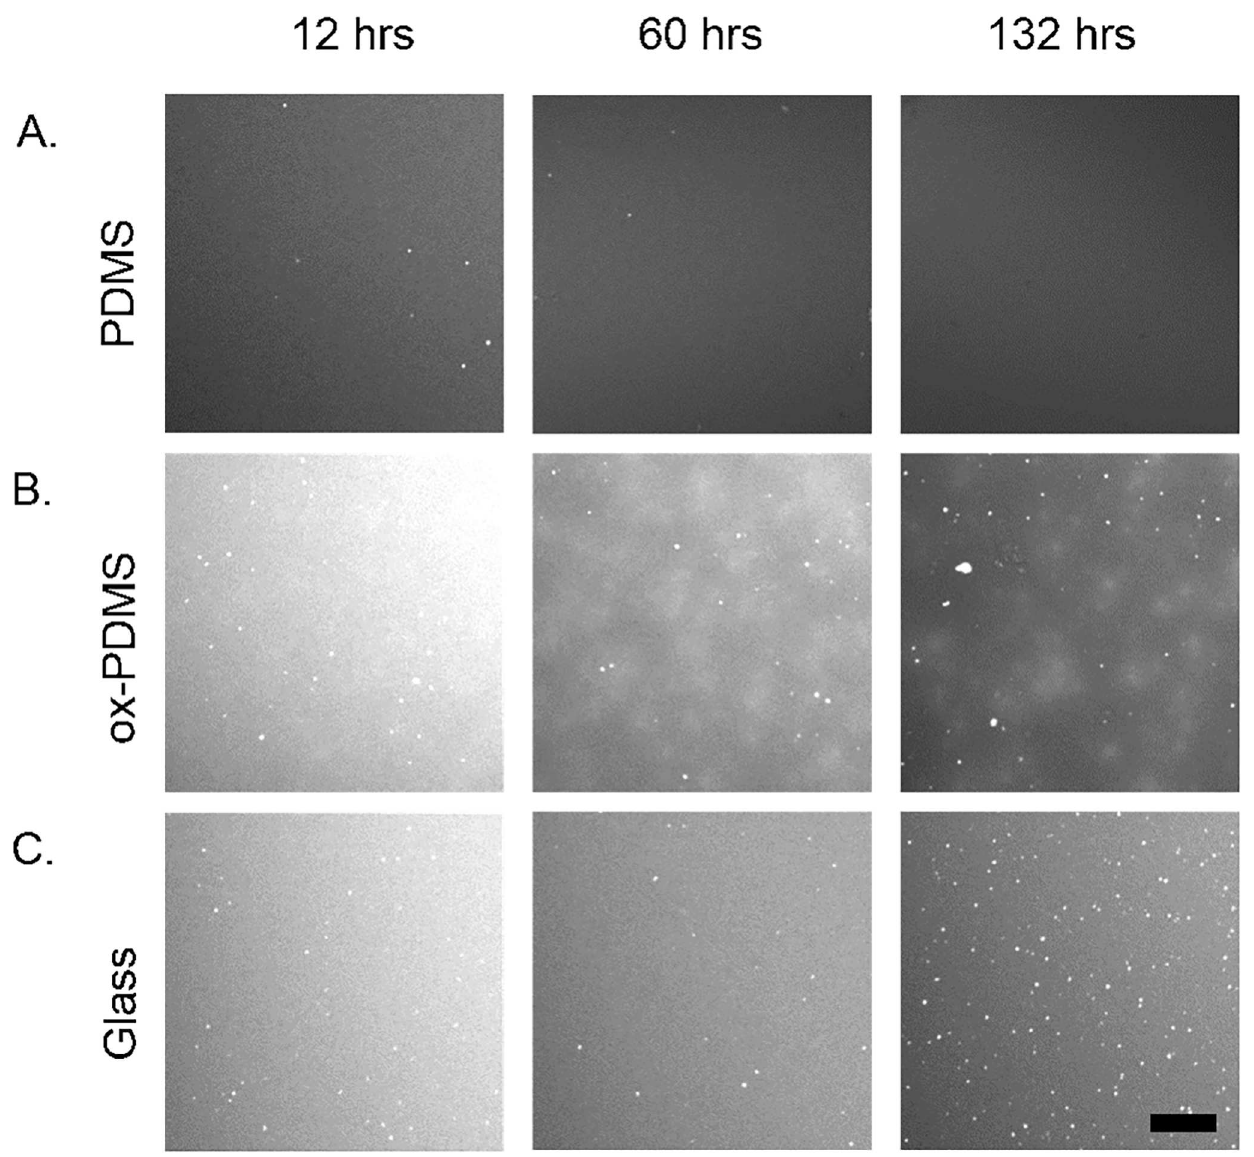
Fig 2. Representative confocal fluorescence images of the lipid layers on PDMS, ox-PDMS, and glass over time. Twelve hours after formation, all the lipid layers appearedsimilar to when they were first prepared.A) The monolayeron PDMS remained homogeneous and unchangedfor 132 hours. B) The lipid bilayer on ox-PDMS appearedmottled at 60 hours. C) The homogeneity of the lipid bilayer on glass remains largely unchanged over the course of 132 hours. A large number of adsorbed SUVs form on the surface. Scale bar 10 μ